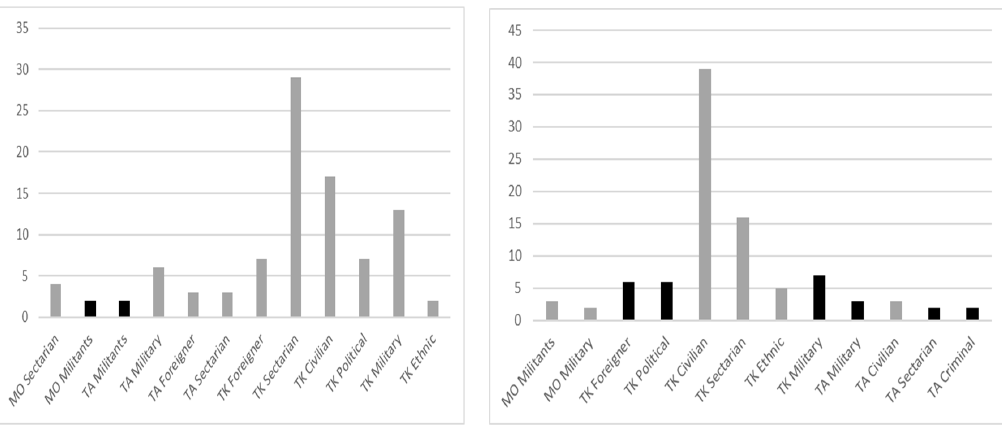
Figure 9. Cluster analysis for Punjab ( left ) and Sindh ( right ), collectively for all events, for the time period 1988–2012.